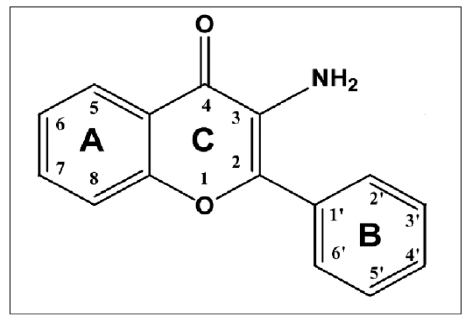
Figure 1. Structural formula of 3-aminoflavone.